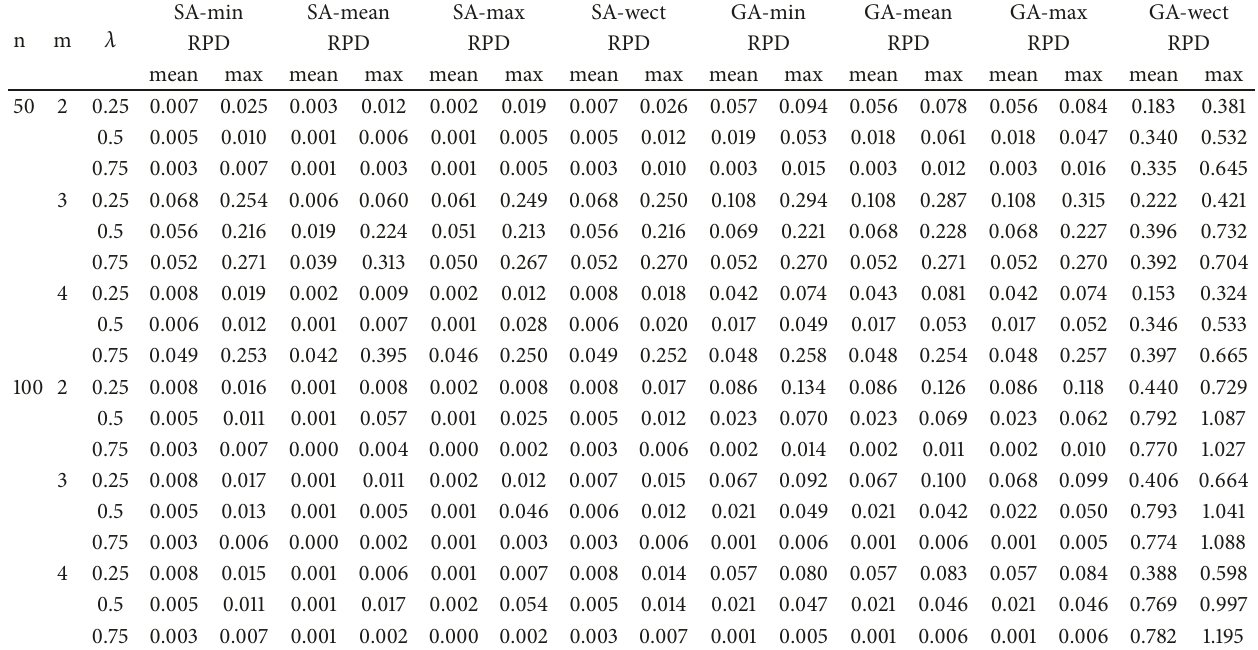
Table 10: The RDP results of the SAs and GAs for large number of orders.